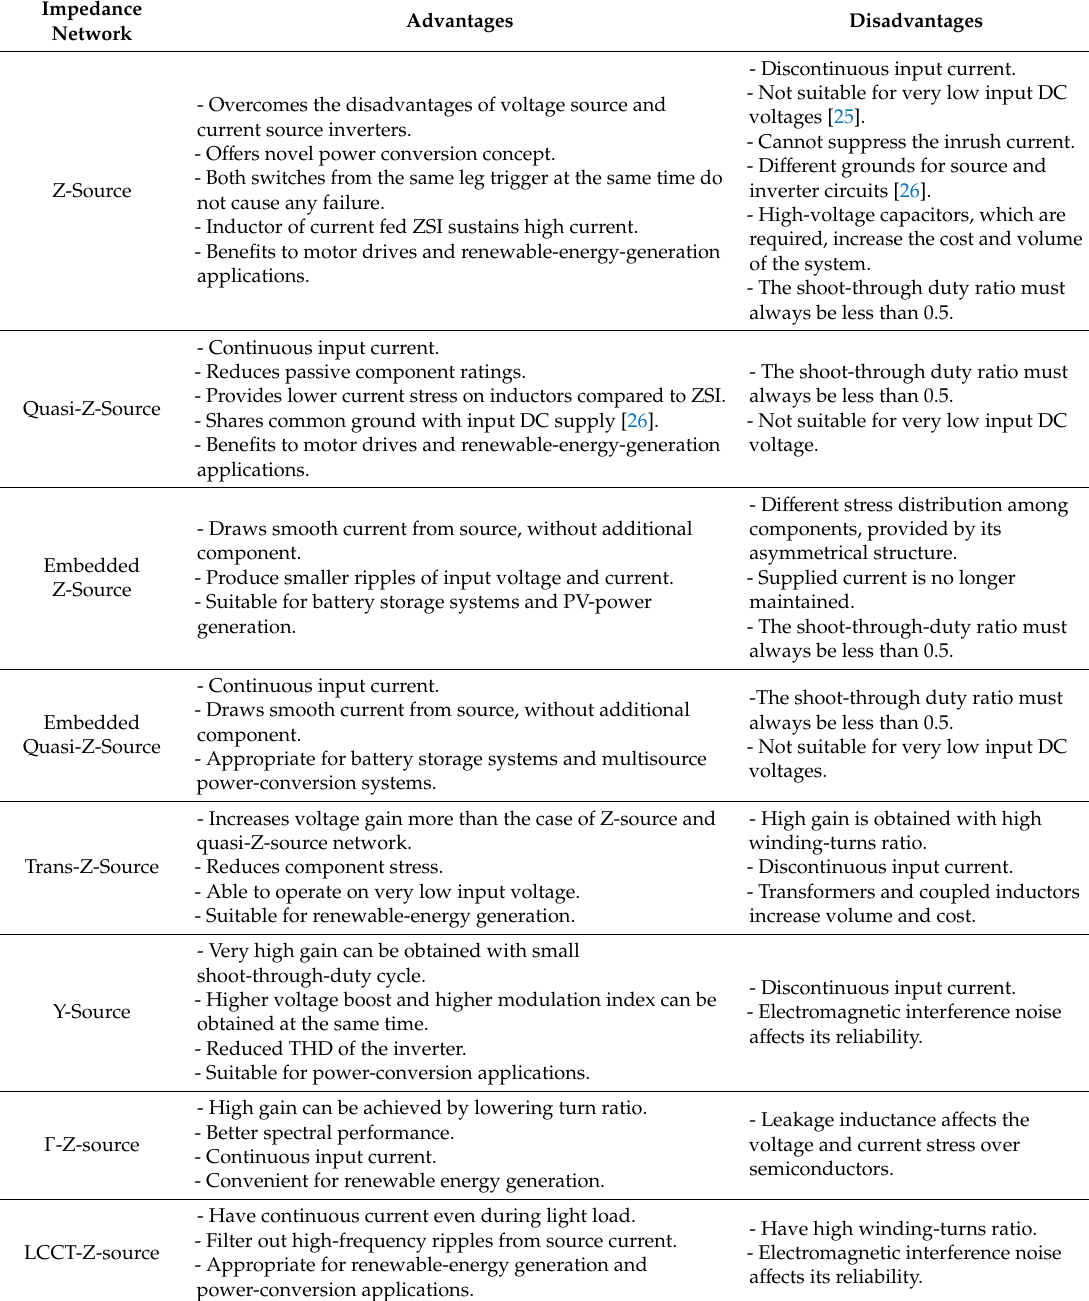
Table 2. Summary of the impedance source network topologies’ advantages and